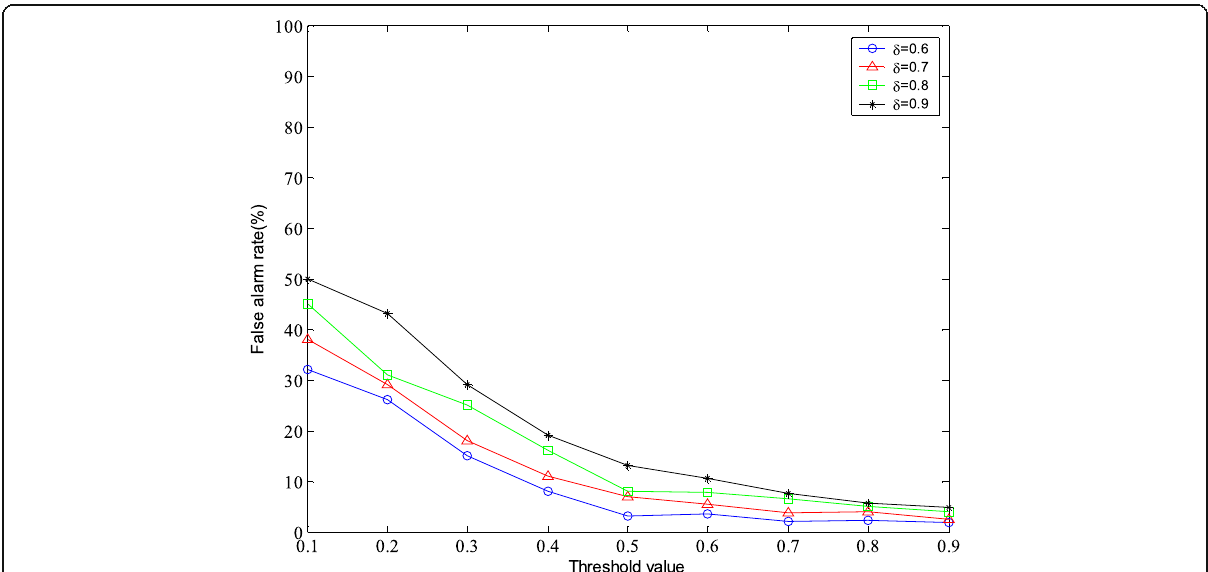
Fig. 2 False alarm rate. The false alarm rate demonstrates the ratio of normal data mistakenly detected as